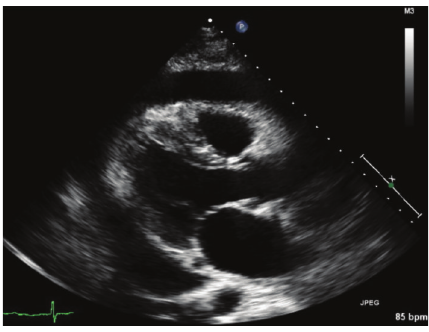
Figure 3: Transthoracic echocardiography (TTE) performed on day one of the hospitalization. The image shows a pericardial